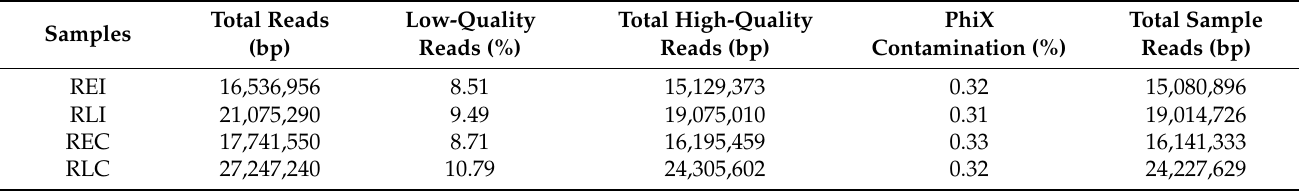
Table 1. Total raw paired-reads of RNA-seq and the filtered reads after the quality assessments and trimming and removal of PhiX contaminants for oil palm root tissues under different treatments.